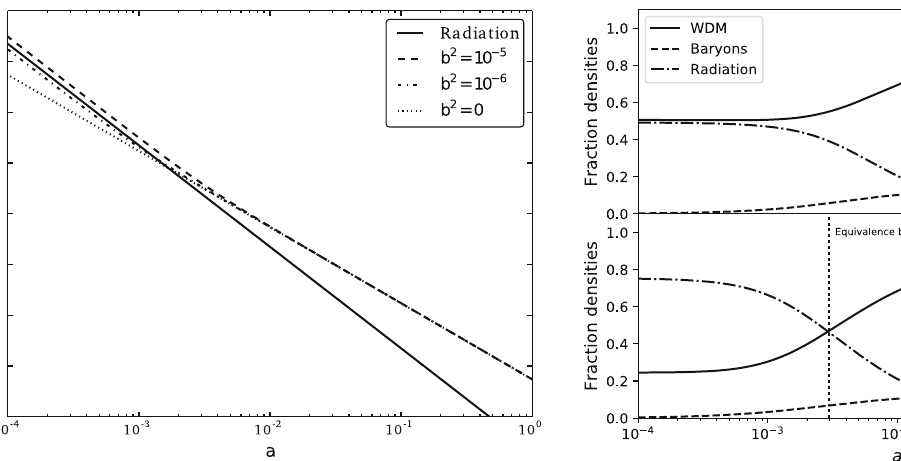
tion. Right panel: Fractional abundances as functions of scale factor for baryons, radiation and WDM for b 2 = 10 − 5 (top) and b 2 = 10 − 6